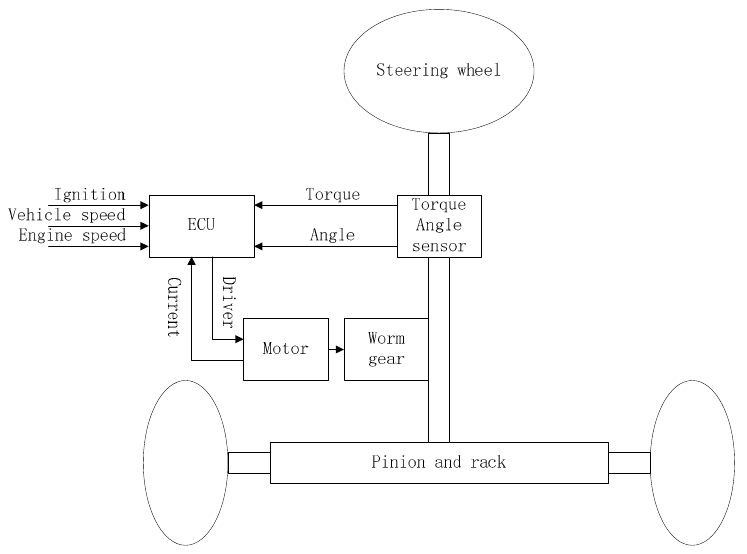
Figure 1. Mechanical structure of Electric Power Steering (EPS) systems.